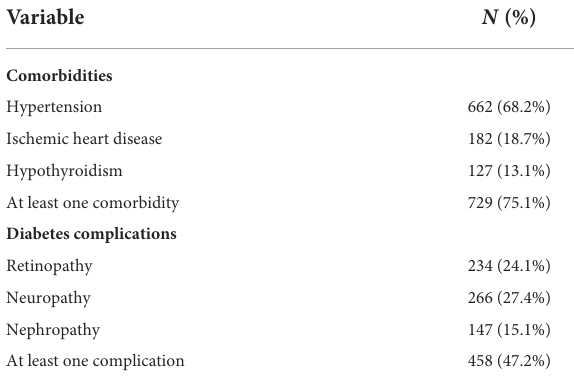
TABLE 1 Socio-demographic and clinical characteristics of the study population ( N = 971).